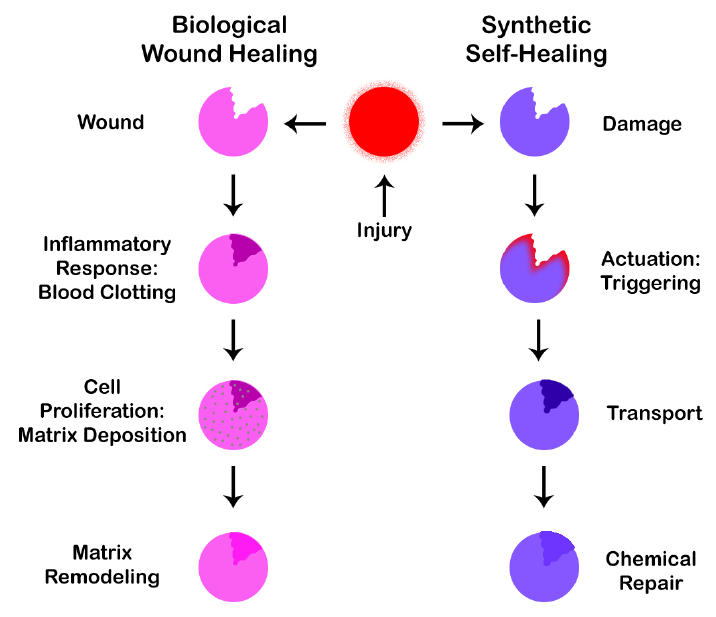
Figure 6. Similarities between the biological wound healing process and the synthetic self-healing